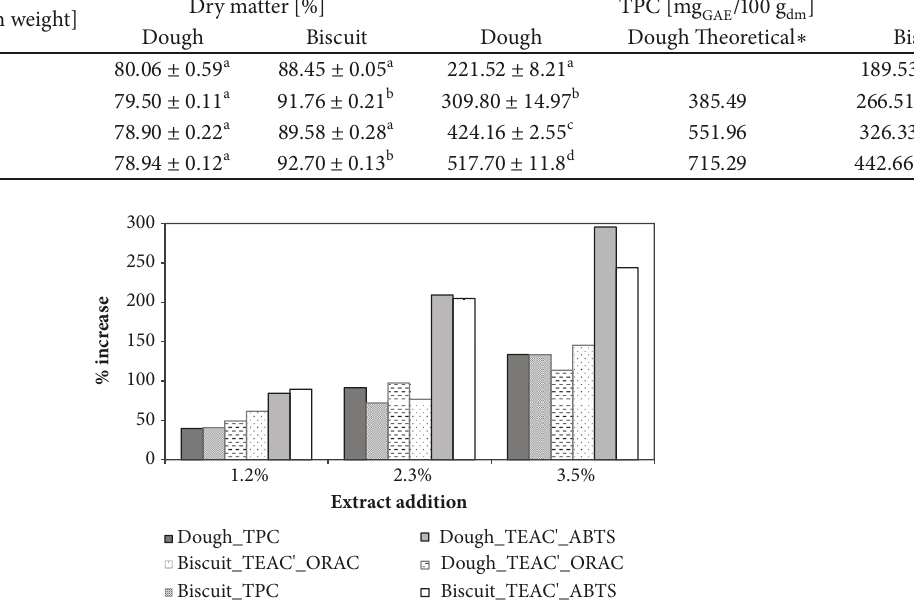
Figure 1: Influence of grape skin extract addition at different levels (1.2, 2.3 and 3.5% on dough weight) on the % increase of total phenols content (TPC) and of specific antioxidant capacity (TEAC’ = 𝜇 mol Trolox (cid:2) / g dm and TEAC = mol Trolox (cid:2) / mol GAE ) of dough and biscuit, based on the ABTS assay or the ORAC assay. Error bars indicating ± SD are not included since values were calculated from mean values of Table 2 and Figures 2 and